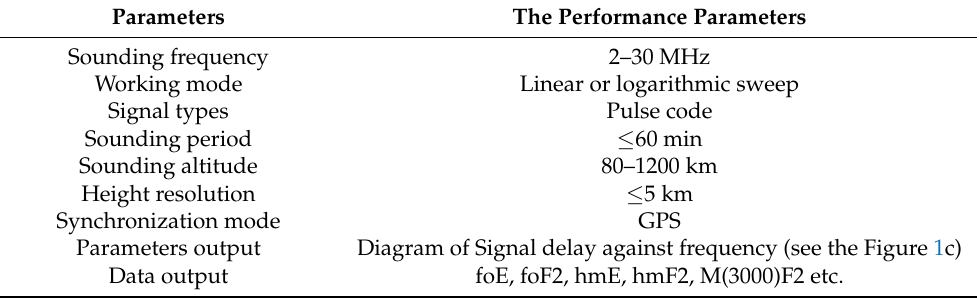
Table 2. The performance parameters of vertical sounding equipment.